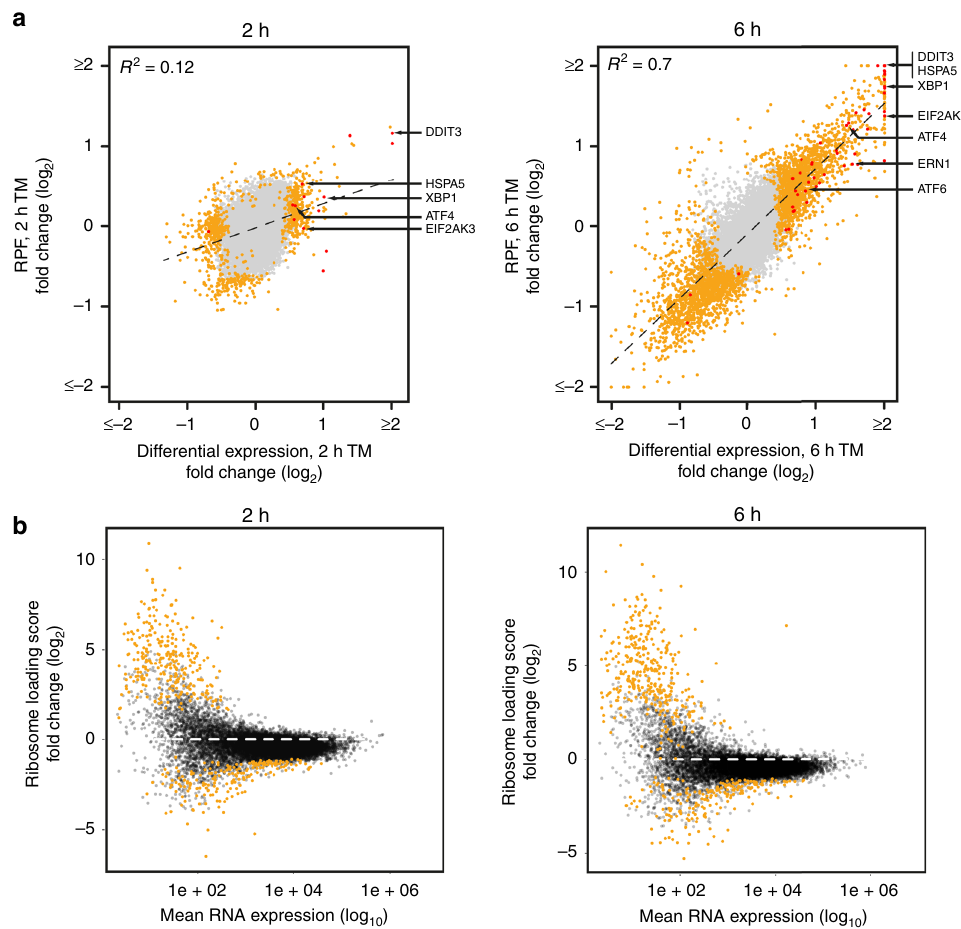
Fig. 2 Global analysis of UPR-mediated translation regulation. a Comparison of differential RNA expression and changes to RPF abundance of protein- coding RNAs after 2 h (left panel) or 6 h (right panel) of TM treatment. Loci with a P -value below threshold are depicted yellow, plotted are log2-fold changes of mean values. b Analyses of ribosome loading scores of protein-coding RNAs after 2 h (left panel) and 6 h (right panel) of TM stimulation. Note the overall reduction in ribosome loading (for reference the dashed line indicates no change in ribosome loading). RNAs that exhibit statistically signi fi cant changes in ribosome loading are shown in